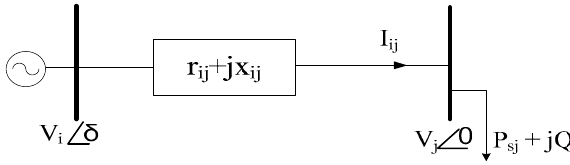
Figure 1. Representation of radial network between two nodes.